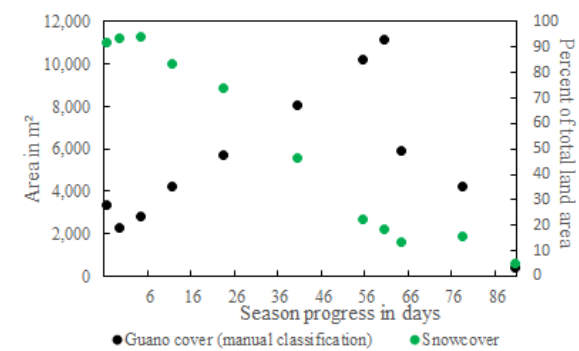
Figure 12. Season 2017/18: comparison between snow cover and guano extent. Percent equals total land area in the survey